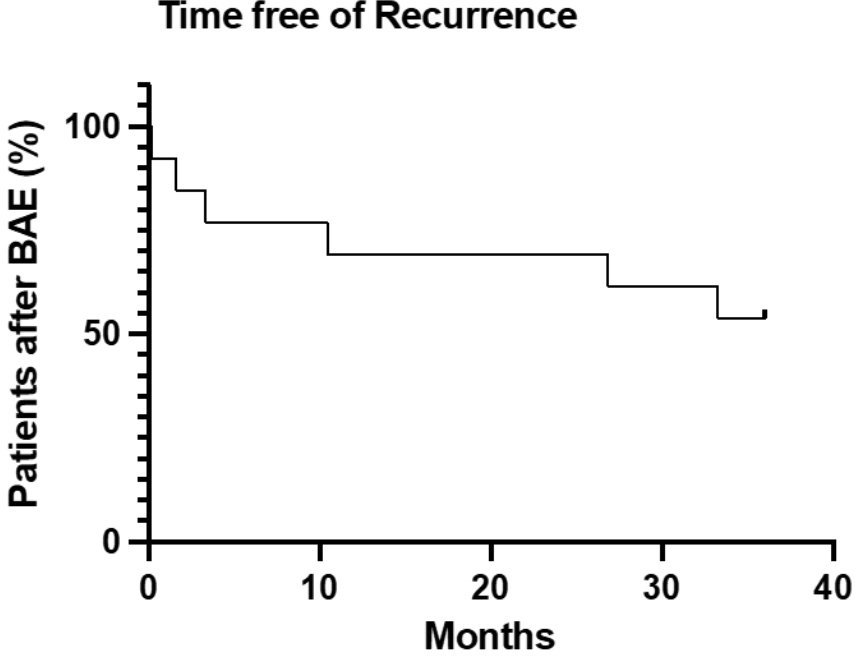
Figure 3. Survival analysis of time free from hemoptysis or death after BAE treatment.